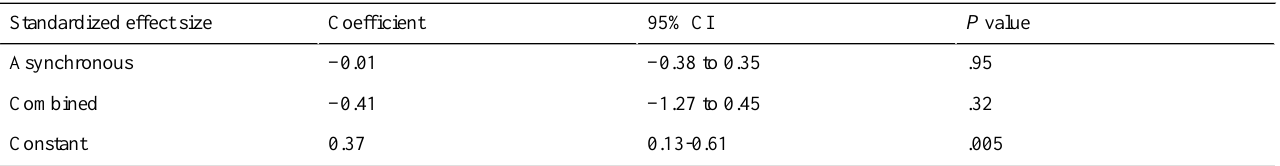
Table 1. Metaregression comparing the effect of synchronous versus asynchronous versus combined electronic health interventions on physical activity behavior change, analyzed using standardized effect size.